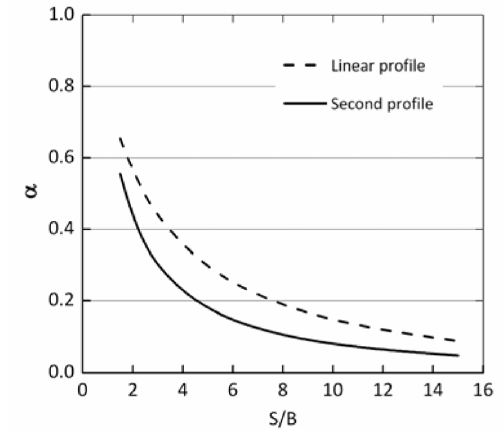
Fig. 13. Interaction factor calculated for the two different soil profiles presented in Figure 12